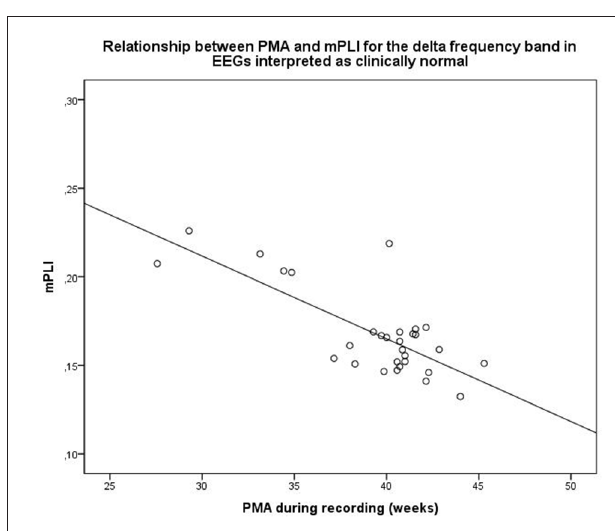
FIGURE 3 | Scatterplot of PMA and mPLI in the delta frequency band in a subgroup with EEG clinically interpreted as normal. Dots correspond to individual subjects ( N = 30). PMA = postmenstrual age, mPLI = mean phase lag index.